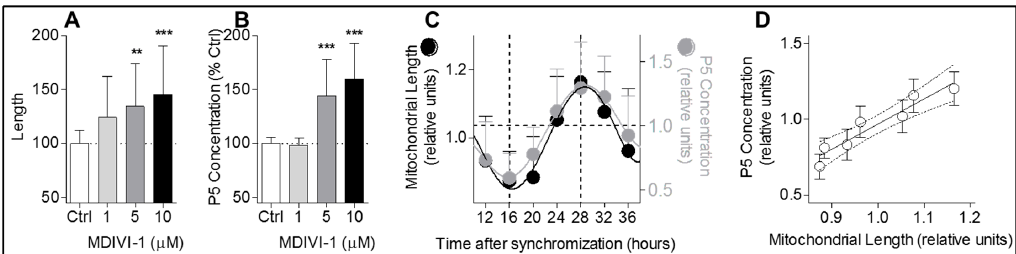
Figure 4. Changes in mitochondrial morphology correlate with rhythmic pregnenolone production. ( A ) Mitochondrial length was quantified after MDIVI-1 (1, 5, and 10 μ M) treatment in A172 glioma